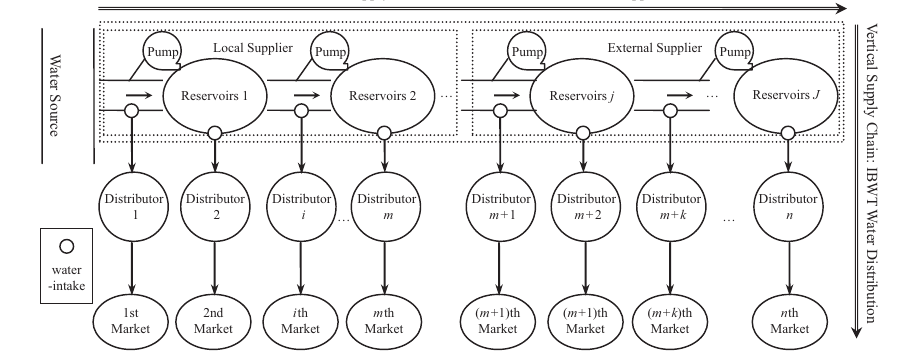
Figure 1. A generic